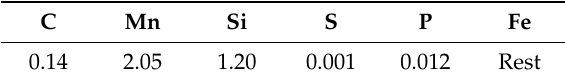
Table 1. Chemical composition of the steel (in mass %).